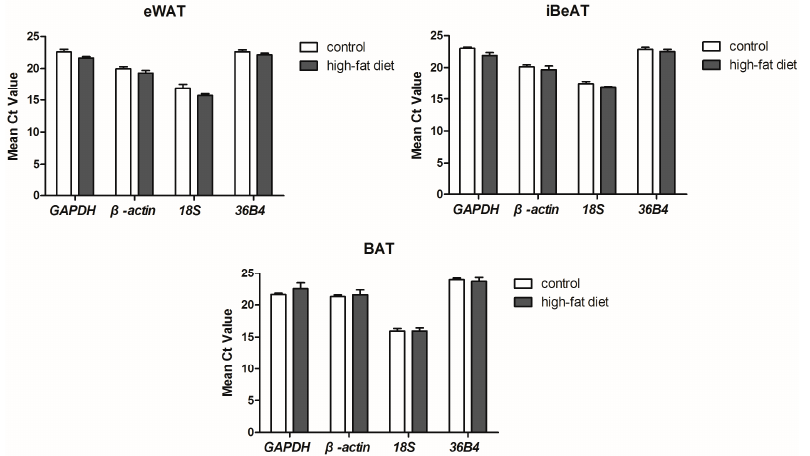
Figure 2. Expression levels of the reference genes in different types of adipose tissues between control and high-fat diet groups (mean ± SEM, n = 6). GAPDH : Glyceraldehyde-3-phosphate dehydrogenase; 36B4 : acidic ribosomal phosphoprotein P0; eWAT: epididymal white adipose tissue; iBeAT: inguinal beige adipose tissues; BAT: brown adipose tissue.